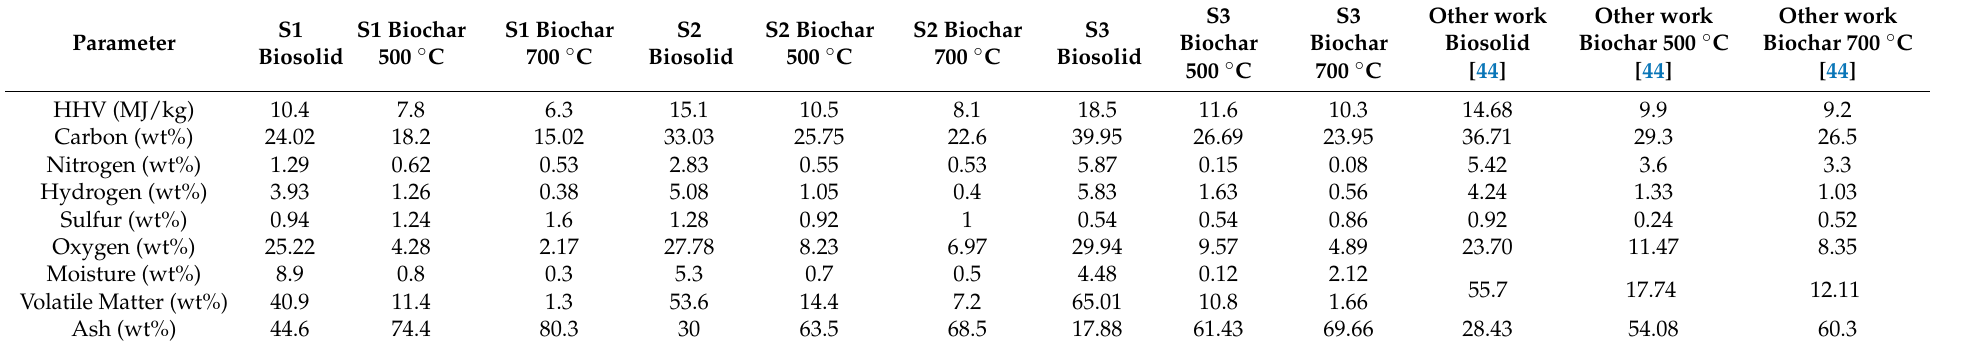
Table 3. Energy, ultimate (dry basis), and proximate analysis (as received).